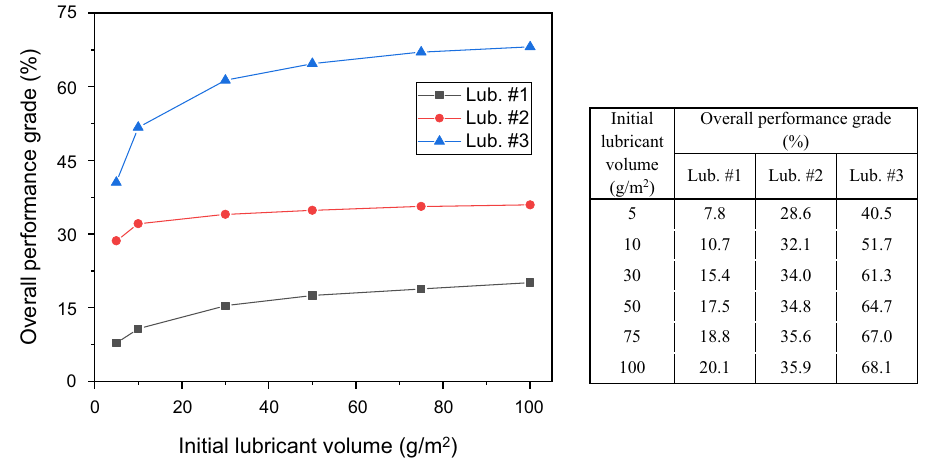
Fig. 5 | Effect of the initial lubricant volume on the overall performance grade (OPG) of the three lubricant candidates for the hot aluminium stamping pro- cess. Evolution of OPG asthe initial lubricant volume increases from 5 to 100g/m 2